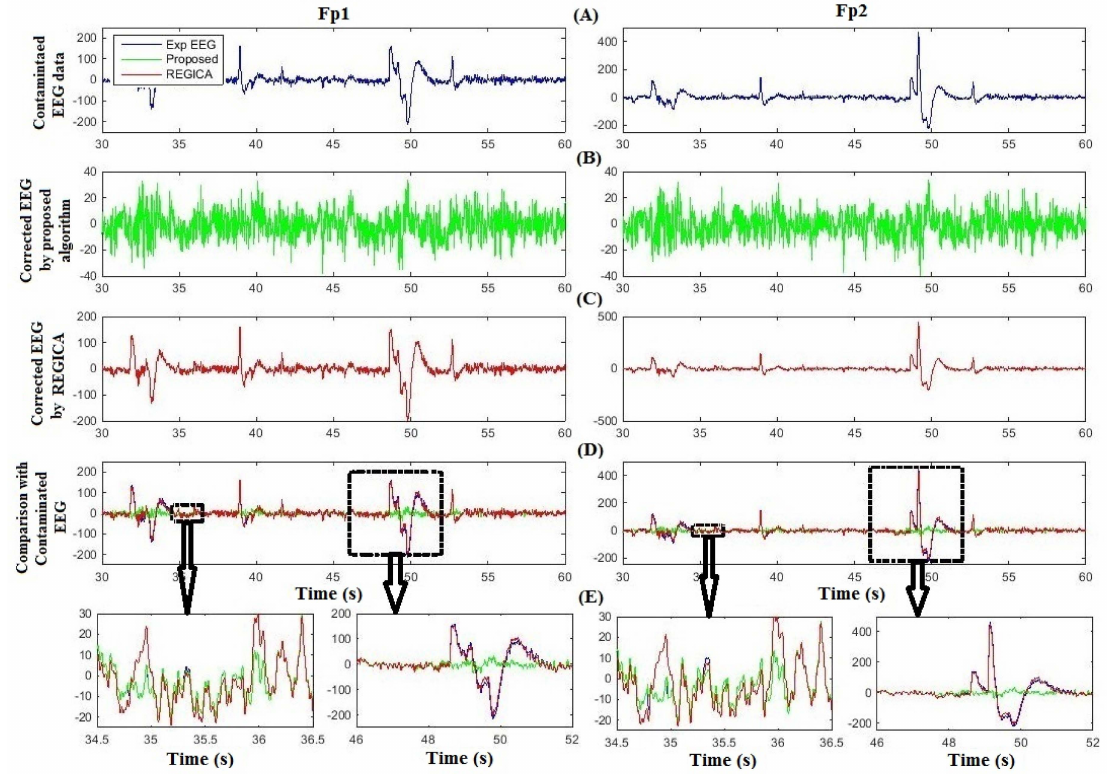
Figure 6. Comparison of the proposed algorithm with REGICA using experimental data. ( A ) Contaminated experimental EEG data at Fp1 and Fp2; ( B ) Corrected EEG by the proposed algorithm; ( C ) Corrected EEG by REGICA; ( D ) Comparison of corrected EEG with contaminated experimental EEG; ( E ) Partial enlargement of highlighted